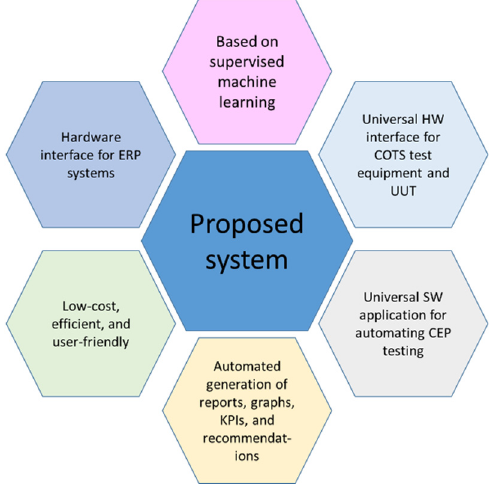
Figure 2. Novel features of the proposed system.